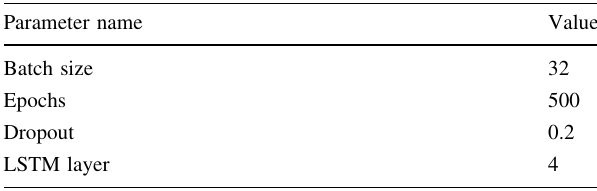
Table 3 LSTM model parameters